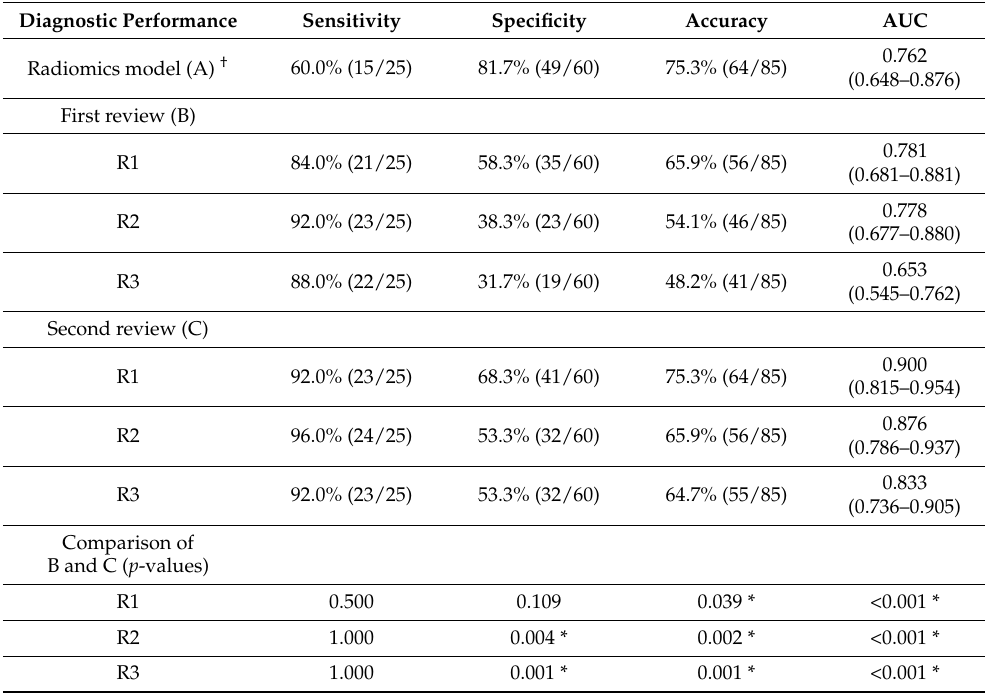
Figure 5. Diagnostic performance of three radiologists (R1, R2 and R3) with and without the assistance of radiomics model (RF) results. Table 4. Comparison of diagnostic performance of radiomics model and